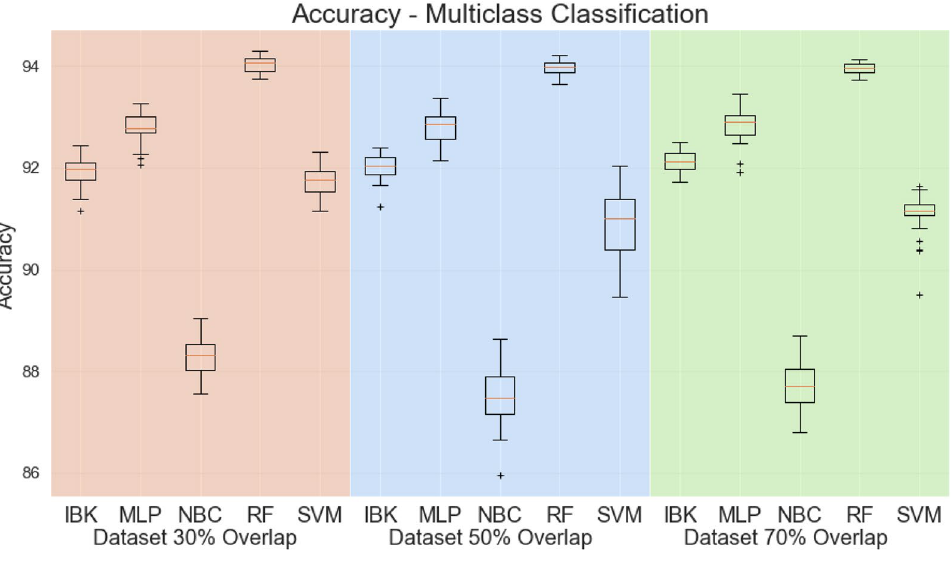
Figure 4. Accuracy for multiclass